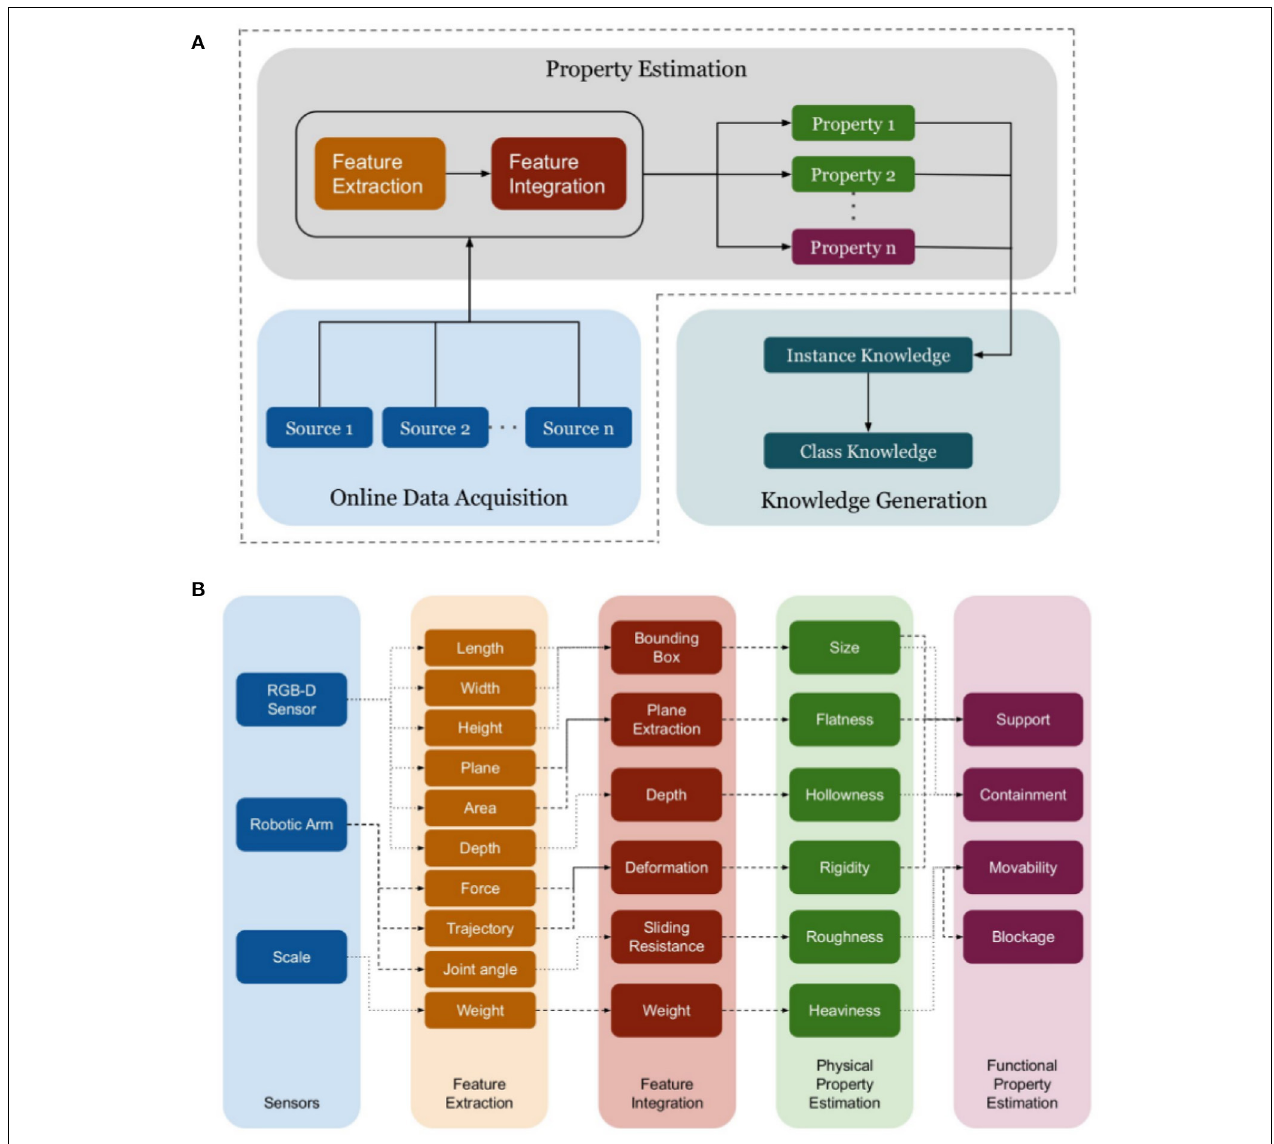
FIGURE 3 | (A) RoCS property extraction framework for extracting sensory data related to various properties and generating robot-centric conceptual knowledge about objects; (B) Proposed property hierarchy and their dependencies (arrow colors chosen to visually distinguish